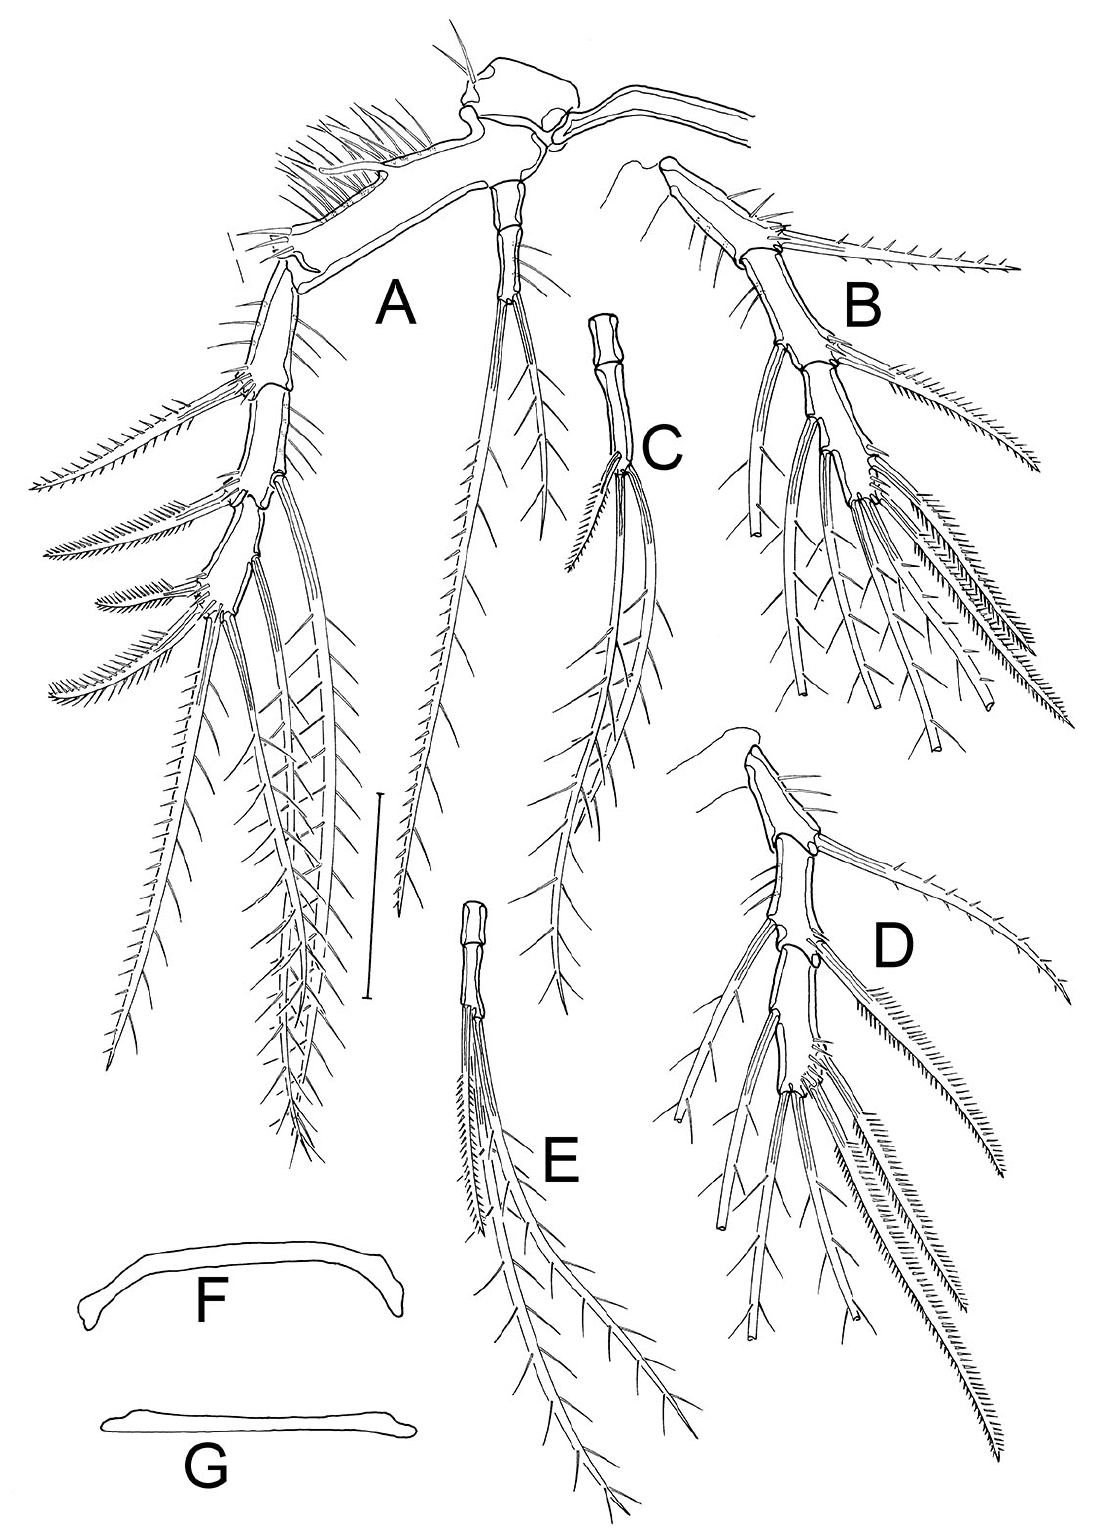
Fig. 12. Paratouphapleura aaroni gen. et sp. nov., female paratype 3 (SMF 37273). A . P2. B . P3 exopod. C . P3 endopod. D . P4 exopod. E . P4 endopod. F . P3 intercoxal sclerite. G . P4 intercoxal sclerite. Scale: 50